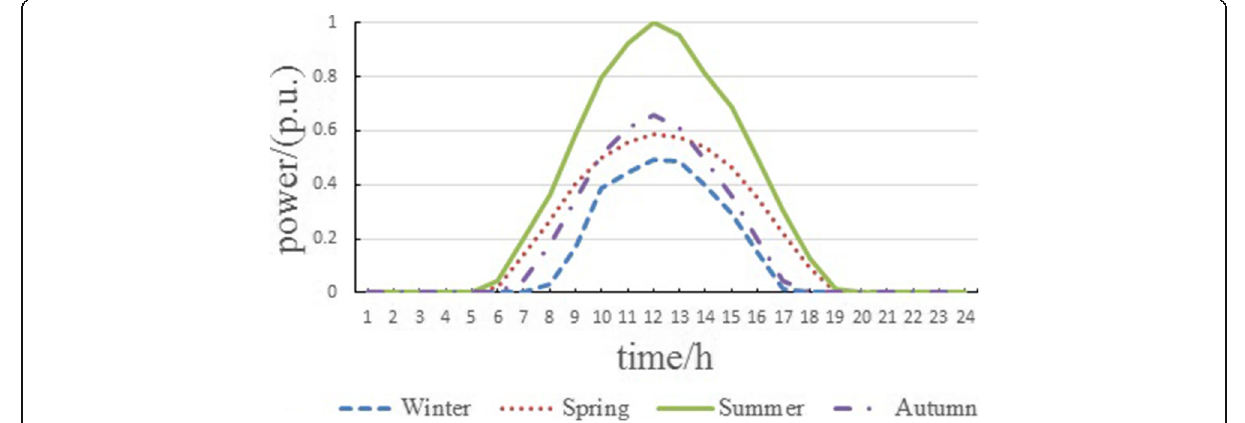
Fig. 4 Typical daily output curves of PV in different